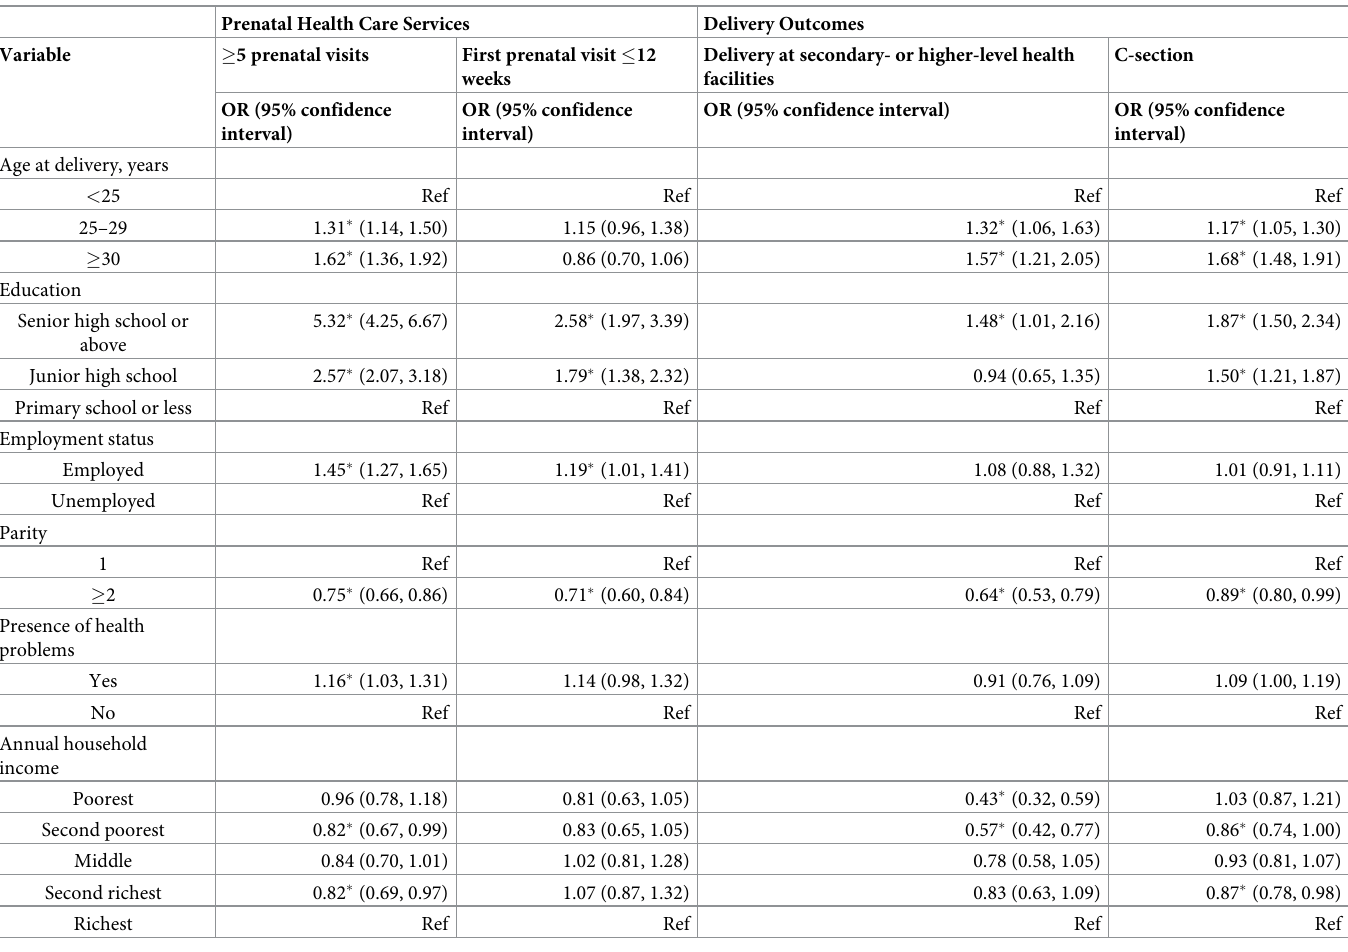
Table 4. Multivariate logistic regression of maternal health services utilization in urban